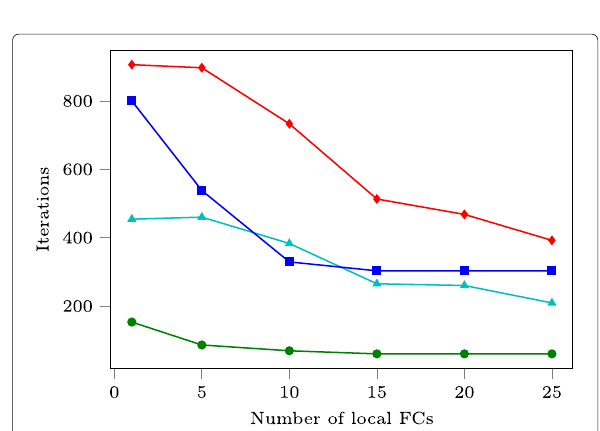
Fig. 8 The impact of adding LFCs in H-CADMM with in-network acceleration. The performance is measured in terms of number of iterations needed to achieve certain